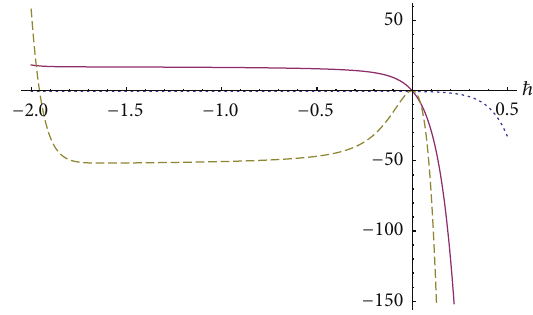
Figure 6: The ℎ -curves according to 17th-order approximation. Dashedpoint: 𝑢(0.01, 0.01) ,solidline: ̇𝑢(0.01, 0.01) ,anddashedline: ̈𝑢(0.01, 0.01) .